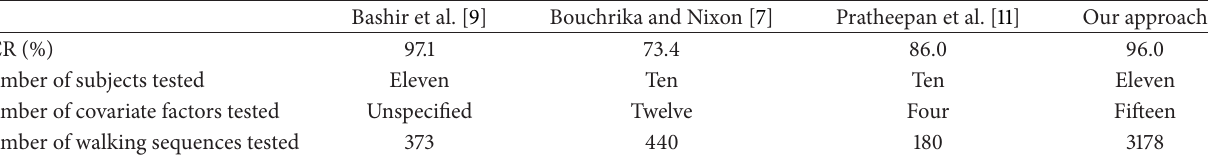
Table 1: Comparison with other systems employing SOTON Small DB.